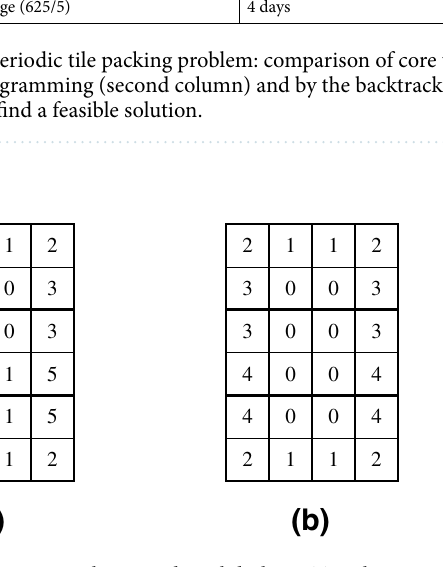
Figure 11. Rectangular periodic valid tilings. Translating a 2 × 3 rectangle over the infinite valid tiling generated from ( a ) or ( b ) leads to 6 different periodic patterns of the same size. Consequently, the tile set allows for 12 periodic rectangles of the size 2 × 3